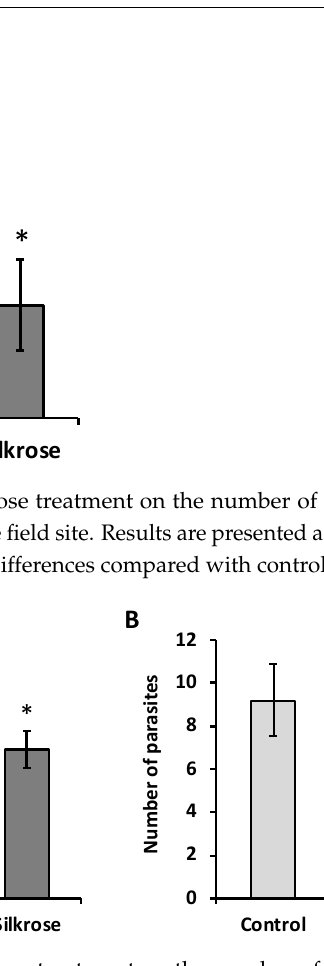
Figure 5. Effect of silkrose treatment on the number of parasites of ( A ) Caligus longipedis and ( B ) Neobenedenia girellae per individual white trevally at aquaculture field site. Results are presented as mean ± standard error. Asterisk indicates statistically significant differences compared with control group (* p < 0.05).